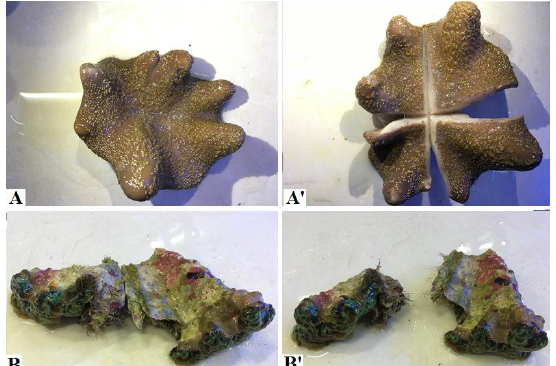
Fig. 1. S. trocheliophorum and E. ancora collection: A and A') S. trocheliophorum were collected and all corals were cut into small pieces; B and B') E. ancora was collected and all corals were cut into small pieces.